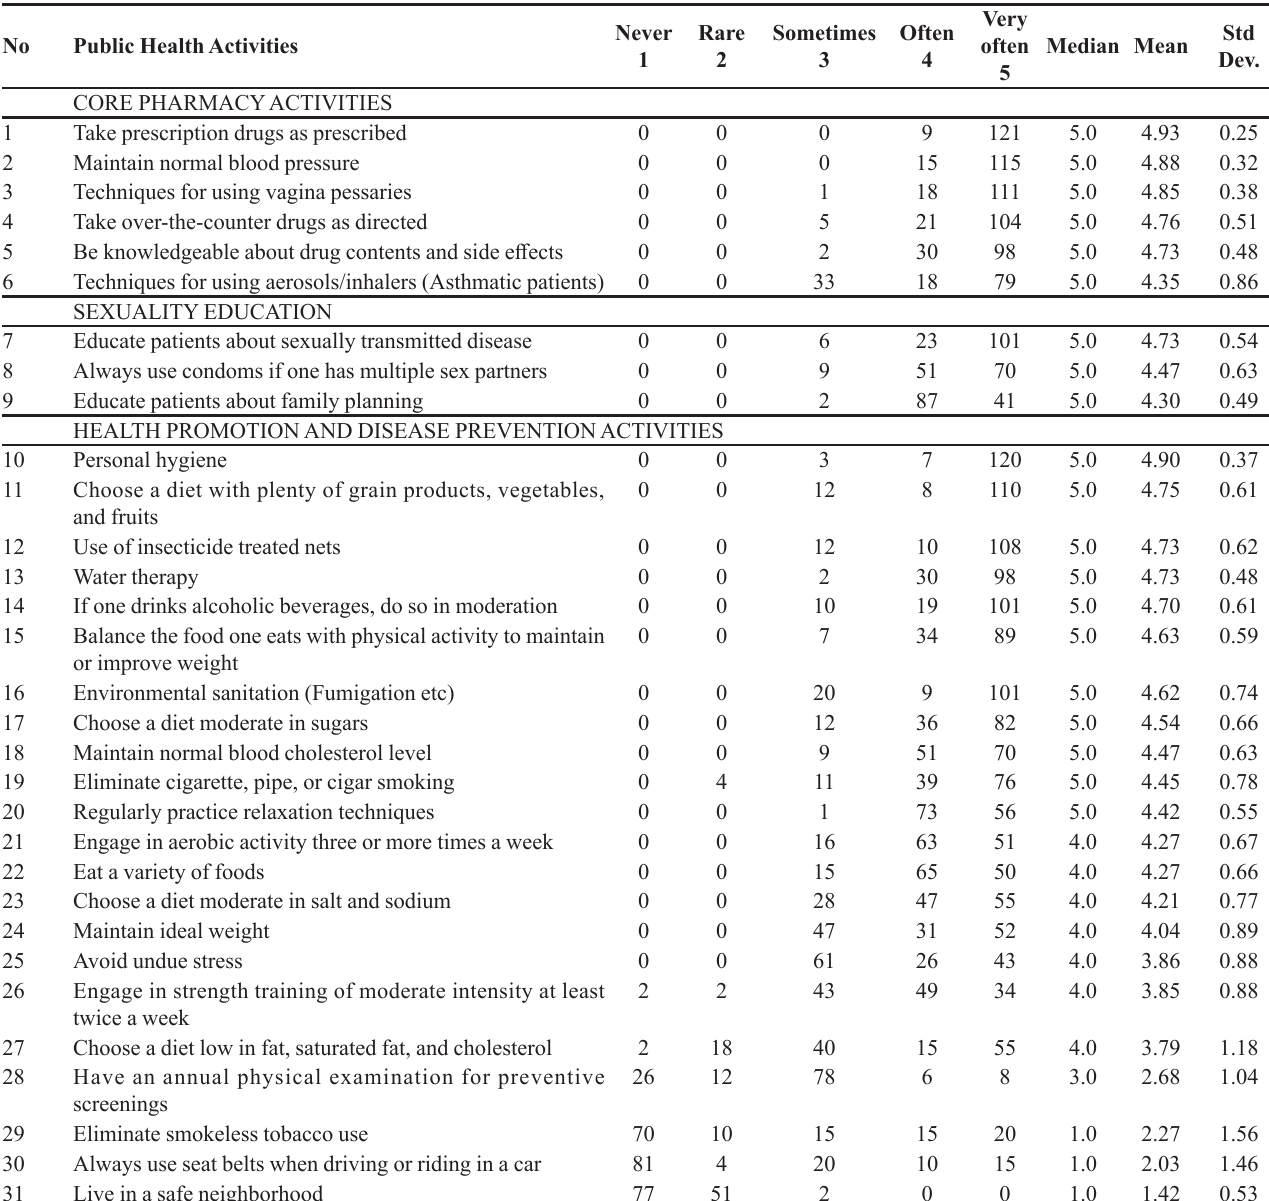
TABLE III - Extent of participation of respondents in public health